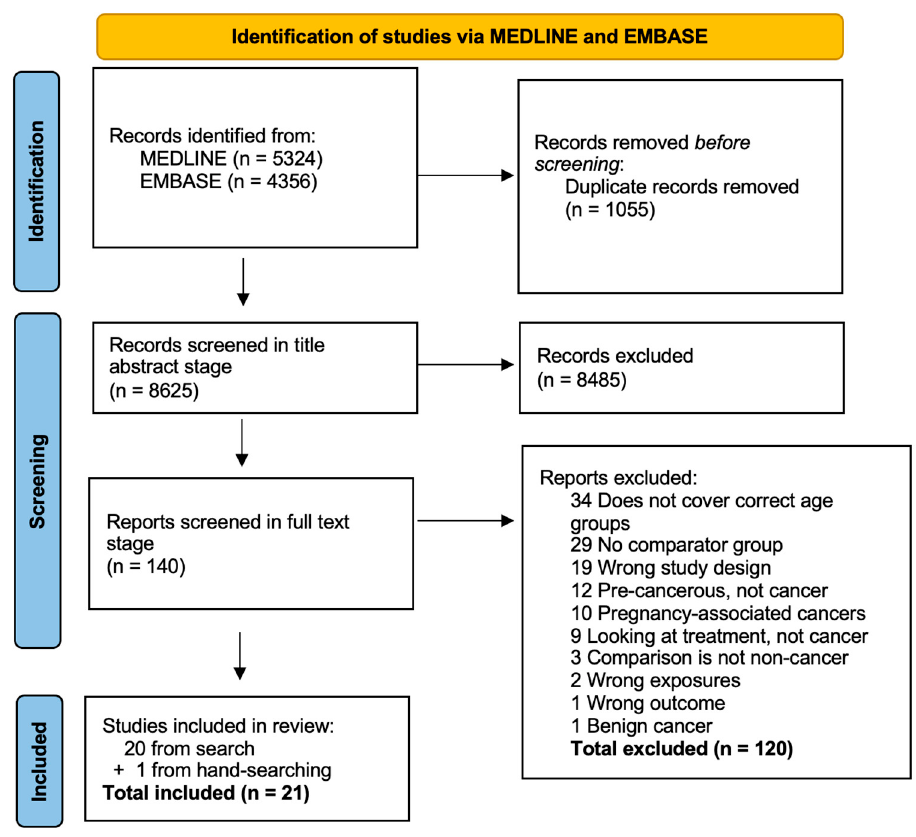
Figure 1. PRISMA flow diagram.